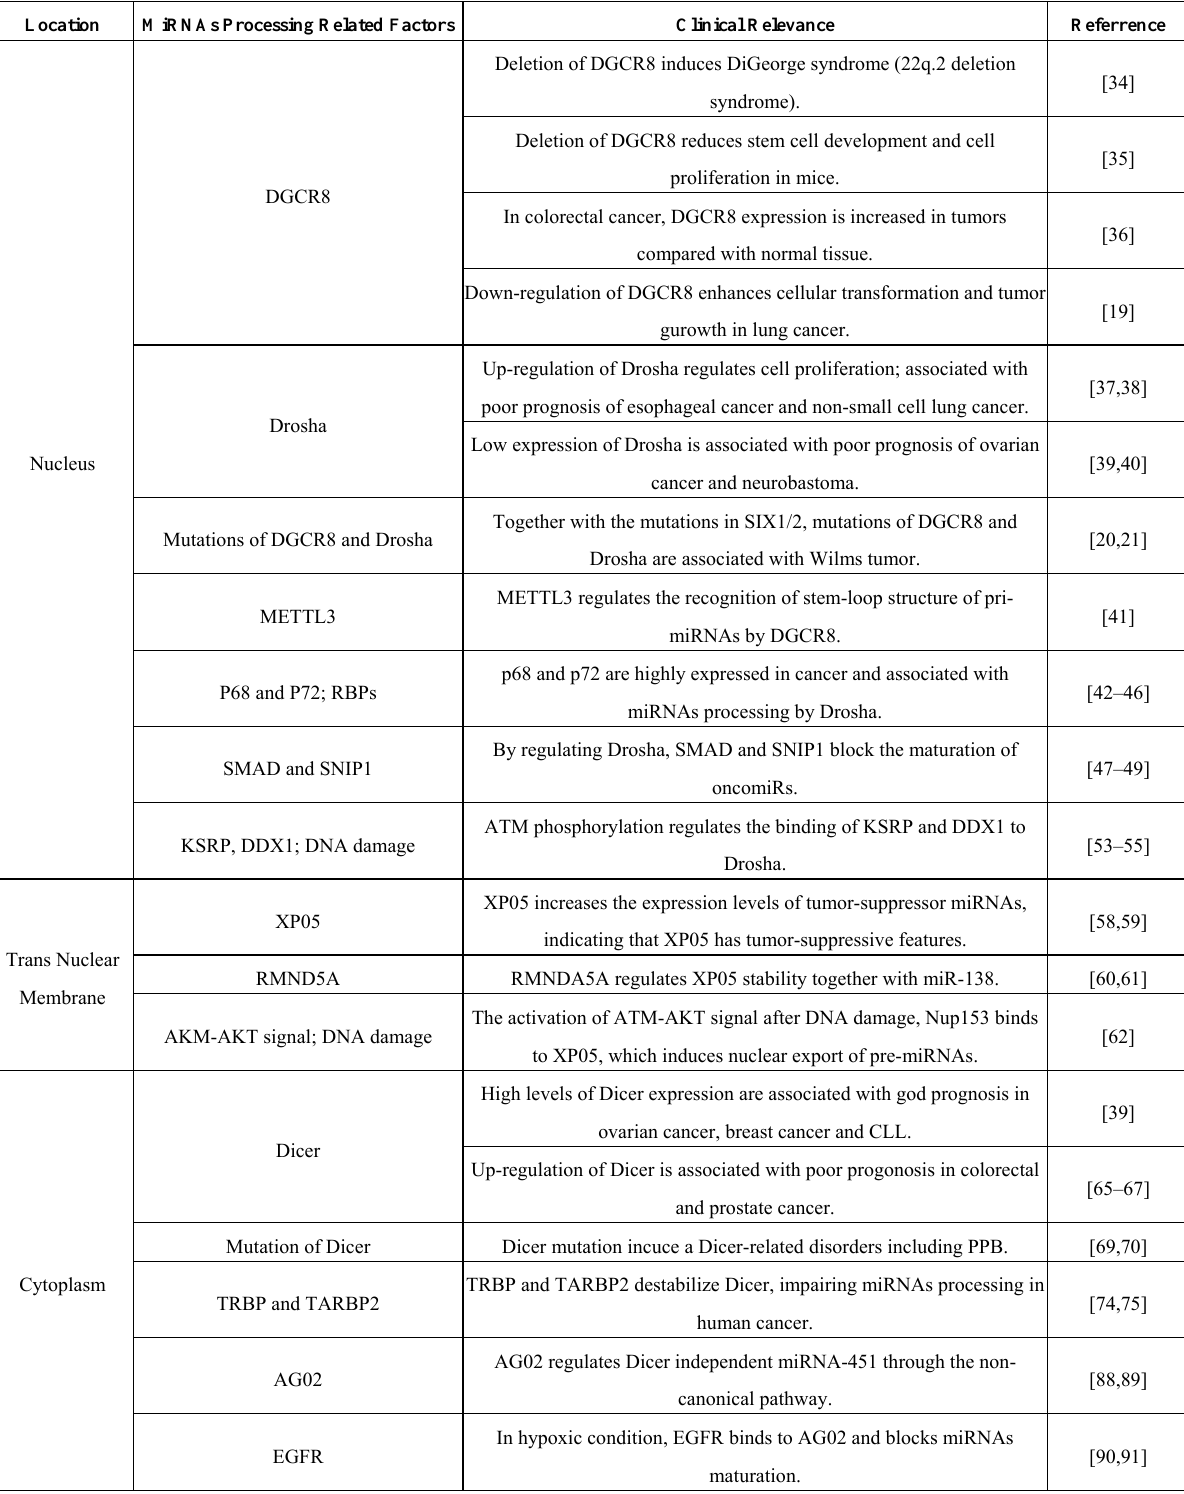
Table 1. Dysregulation of MiRNAs Biogenesis in